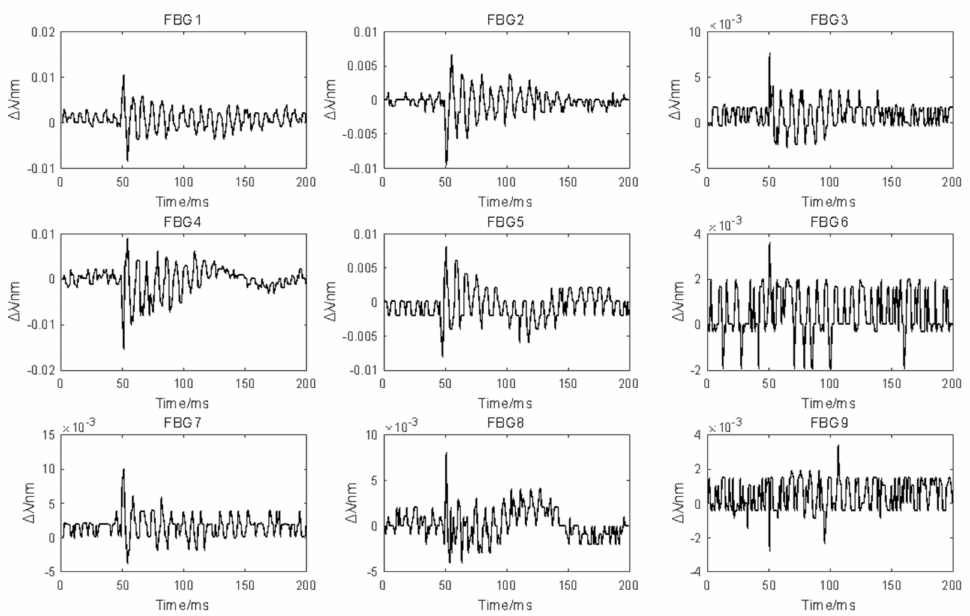
Figure 5. Time-domain response signals of the impact ( − 81 mm, 81 mm) measured by the nine FBG